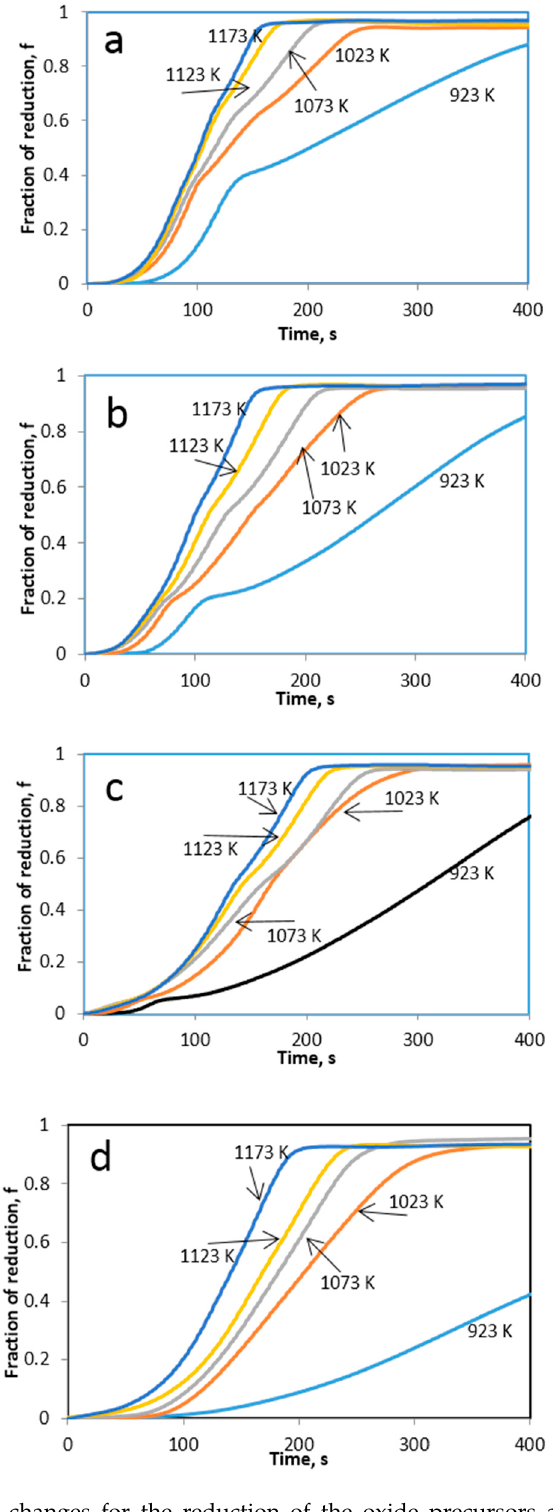
Figure 10. The mass changes for the reduction of the oxide precursors as a function of time. ( a ) Ni/(Ni + W) = 0.7; ( b ) Ni/(Ni + W) = 0.6; ( c ) Ni/(Ni + W) = 0.46; ( d ) Ni/(Ni + W) = 0.4 molar ratio[10].